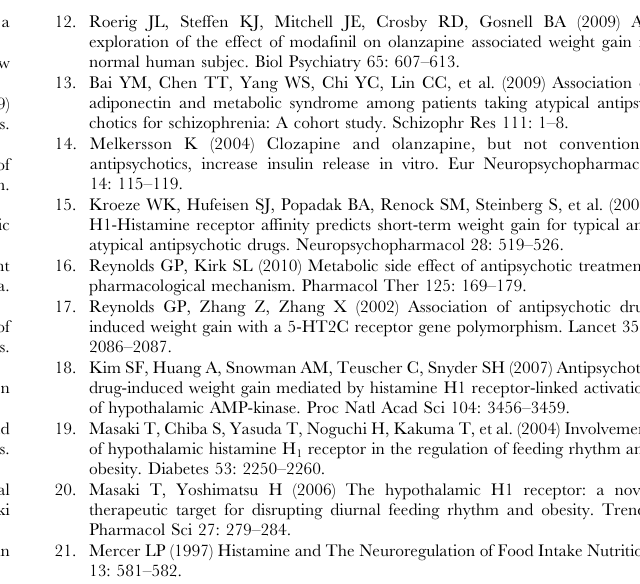
Table S1 Correlation and regression analysis. Pearson’s correlation tests for radioligand receptor binding, metabolic and hormonal parameters in female Sprague Dawley rats following 5 weeks treatment with Olz, OlzEt, OlzHomo (3 mg/kg or 6 mg/ kg), or vehicle